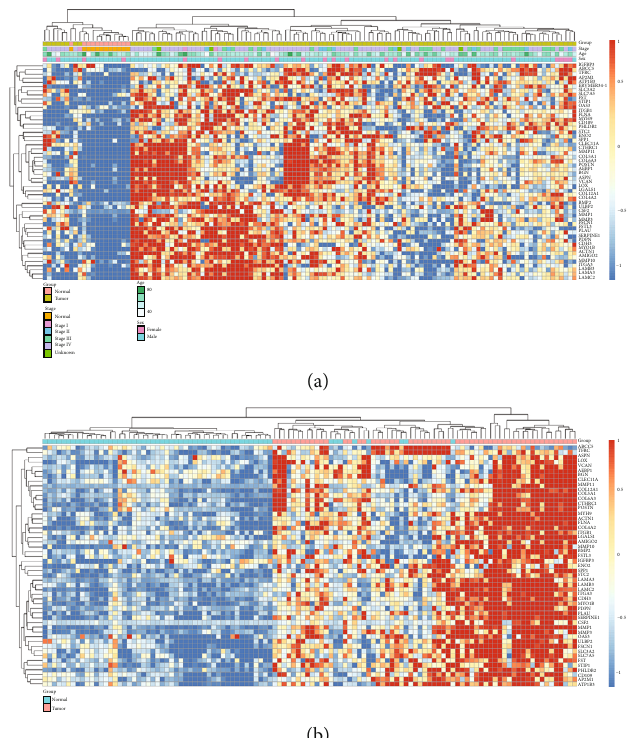
Figure 2: The heatmaps of the di ff erentially expressed and worse-survival-related SMPs: (a) the TCGA dataset; (b)